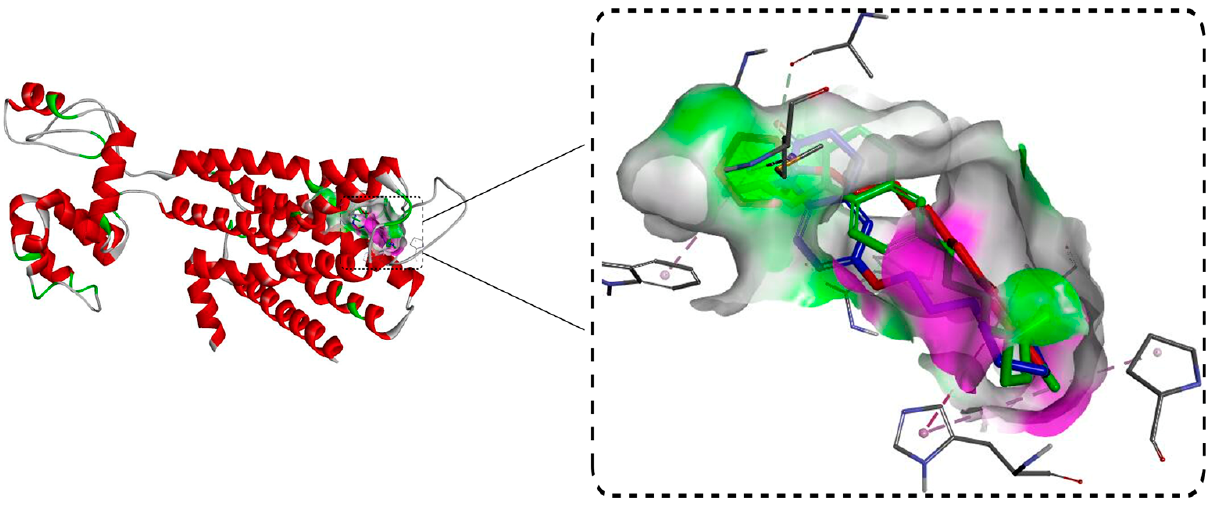
Figure 7. The overlying pa tt ern of compound 2h (blue), 4a (green), and PIT (red) in the binding pocket of the H 3 R.